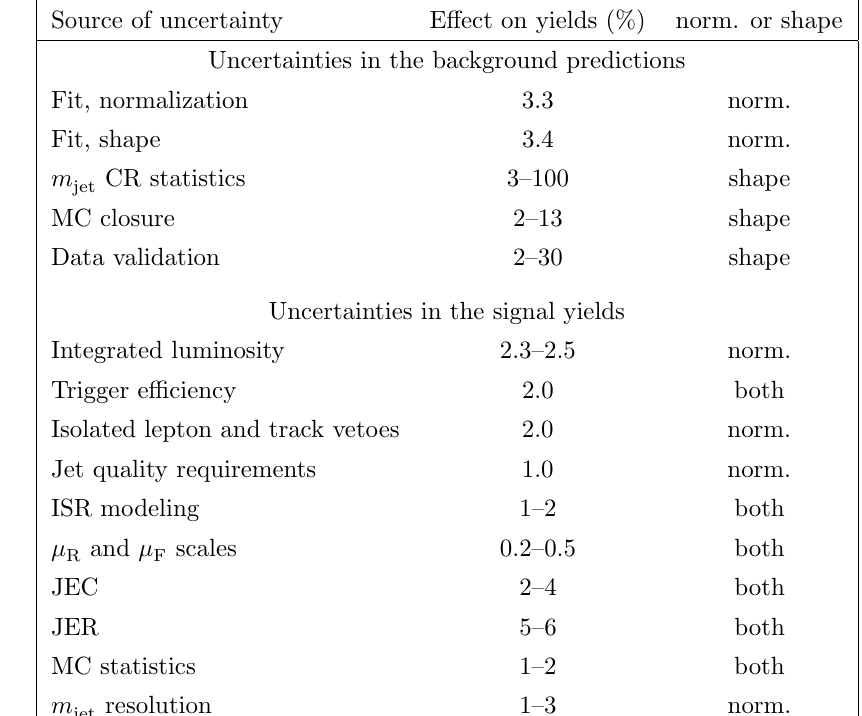
Table 1 . Summary of systematic uncertainties, where the ranges refer to di(cid:11)erent p miss the last column we distinguish uncertainties that a(cid:11)ect the normalizations ("norm."), the shapes of distributions, or